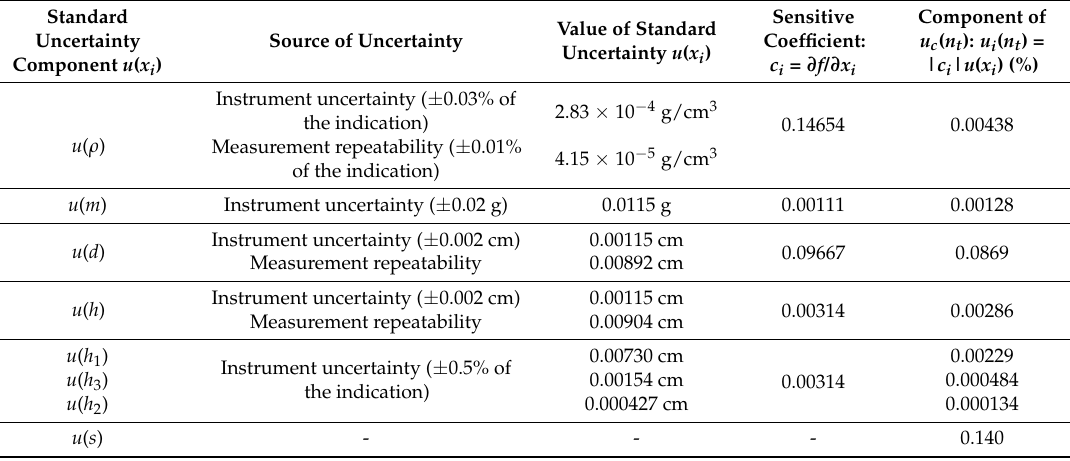
Table 6. Summary of standard uncertainty